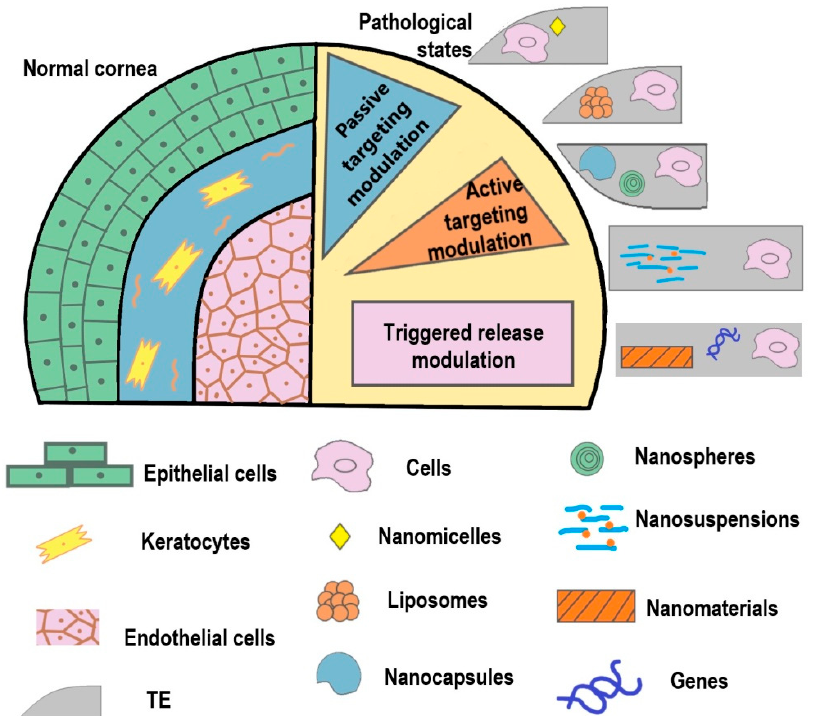
Figure 1. Nanomaterial-based approach in the combined therapy. Top left – healthy corneal tissue. The cornea is a complex vascular-free structure composed of five layers, three of which are of cellular nature (epithelium, stroma and endothelium). Throughout the lifetime, corneal cells are exposed to various traumatic and damaging factors from the external environment and inner disturbances in organism’s functionality. These pathological processes and damaging agents can compromise the integrity of the cornea and lead to vision loss. Top right – pathological corneal tissue. Due to the lack of modern approaches that allow the full restoration of the cornea tissue and vision, new treatment and therapeutic strategies are needed to be introduced. TE- and nanotechnology-based strategies can become a new chapter in the cornea restoration. TE constructs can act through active and passive targeting and controlled triggered release promoting the most effective approach for each set of specific molecular mechanisms and cellular events.